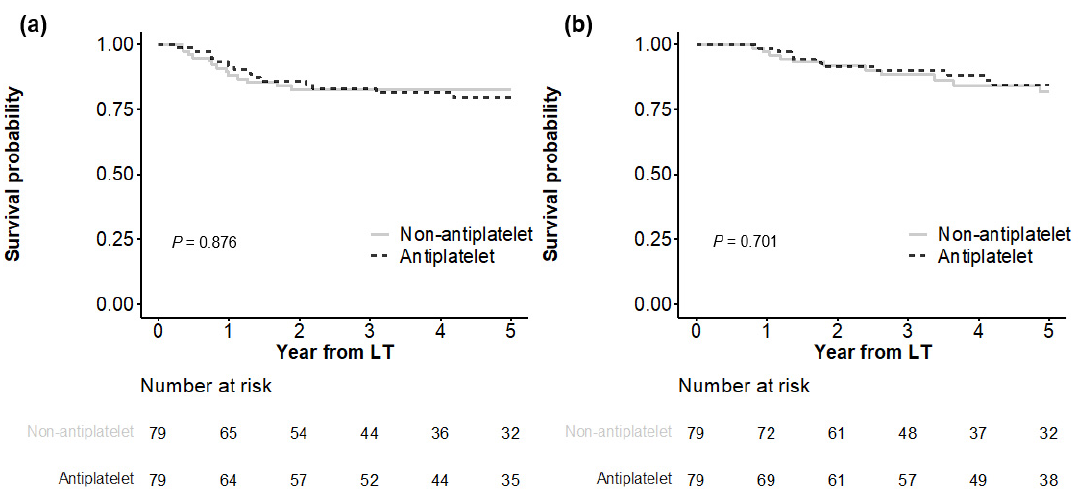
Figure 2. Comparison of outcomes between matched groups. HCC recurrence is shown in ( a ), and HCC-specific death is shown in ( b ).